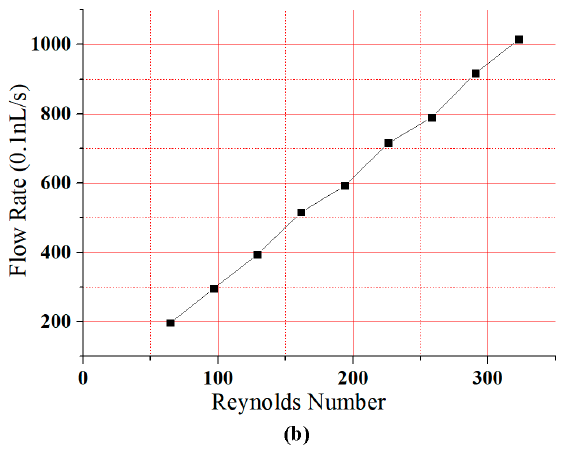
Figure 6. ( a ) The graph between Reynolds number and pressure difference; ( b ) Flow rate vs. Reynolds number for DSMC.